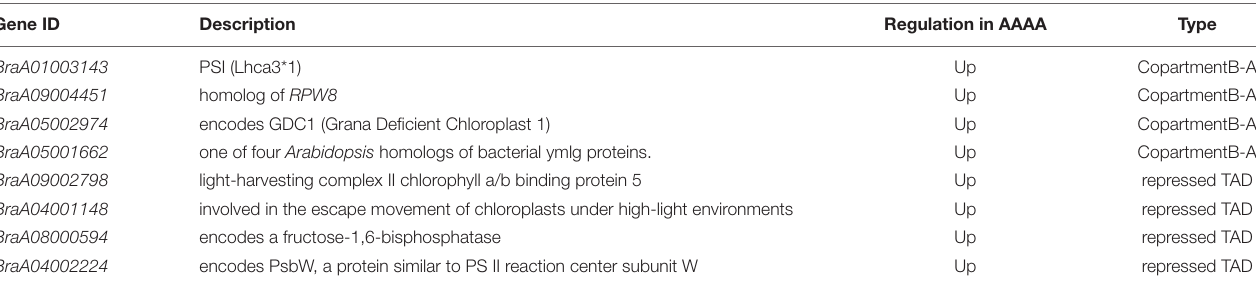
FIGURE 5 | The validation of RNA-seq data. (A) qRT-PCR validation of 15 DEGs. X -axis: Gene ID; Y -axis: log2 (FC), FC (Fold change) represents the ratio of gene expression between AA and AAAA, the logarithm to its base 2 is log2 (FC). (B) qRT-PCR and RNA-seq data correlation analysis. TABLE 1 | The candidate genes for growth advantage screened through a comprehensive RNA-seq and Hi-C